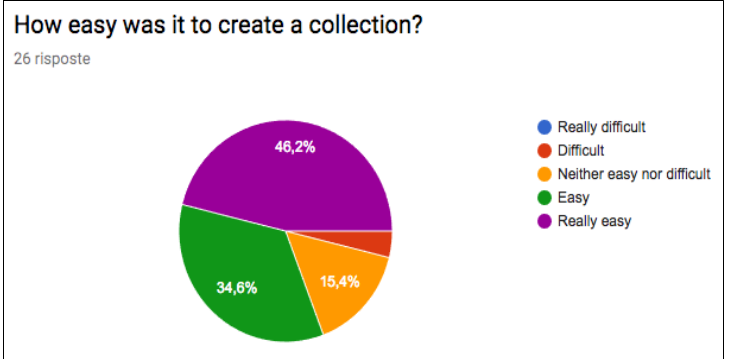
Figure 7. Difficulty in creating a collection